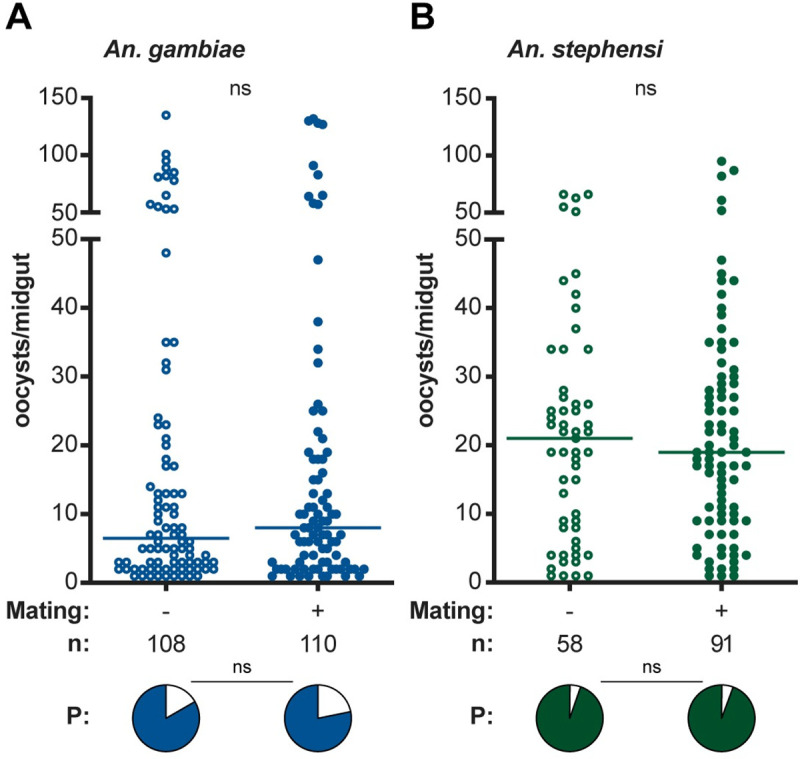
Mating status does not impact P. falciparum laboratory infections in An. gambiae and An. stephensi.Mating status does not affect prevalence (P, indicated with pie charts below the graph) or intensity of infection in (A)
An. gambiae females (prevalence: LRT X21 = 1.08, p = 0.30; intensity: LRT X21 = 0, p = 1.00) or (B)
An. stephensi females (prevalence: LRT X21 = 0.007, p = 0.93; intensity: LRT X21 = 1.47, p = 0.23). The data from this graph are from three replicates for each Anopheles species. Pairwise comparisons are computed via estimated marginal means. Lines represent medians, and n represents all data points including females that failed to develop oocysts. Females that developed no oocysts are omitted from the dot plots to represent intensity of infection. Open circles represent virgin females, closed circles represent mated females. ns = not statistically significant.